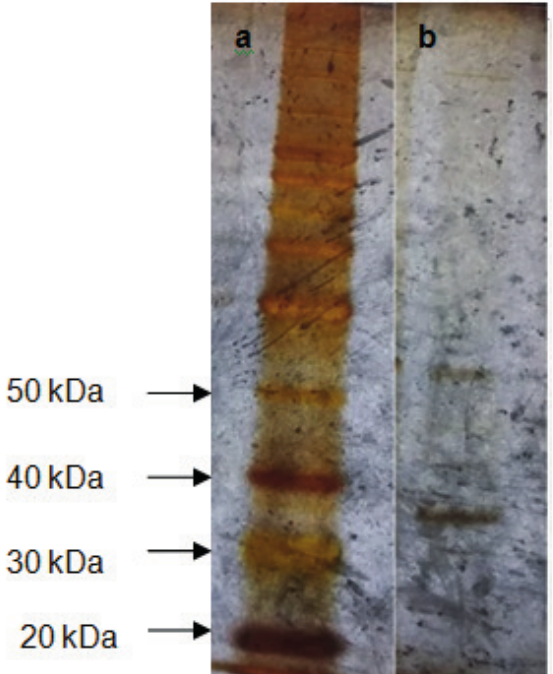
Figure 4 - Polyacrylamide denaturing gel (12% SDS-PAGE). a : molecular weight marker, b : crude extract of the enzyme. The gel was stained with silver